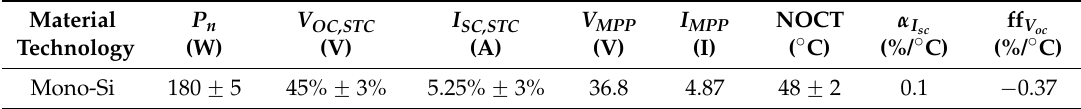
Table 1. Electrical parameters at standard test conditions (STCs) (except for NOCT).